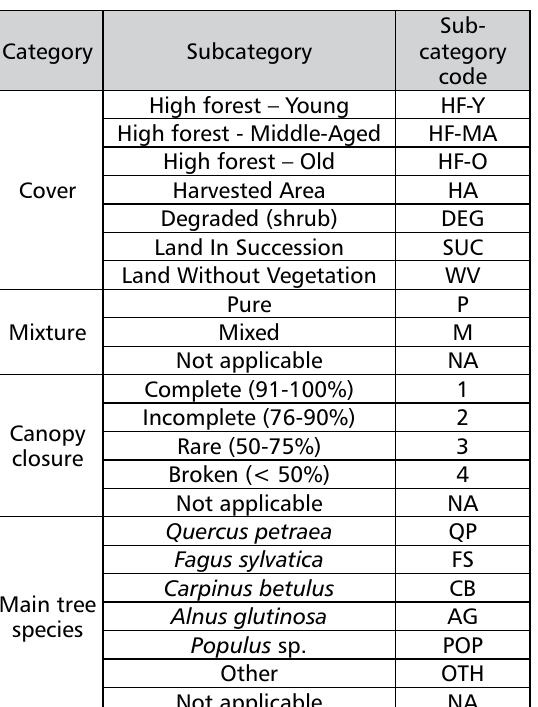
Categories for forest and forest land classification for photo-interpretation of digital aerial images